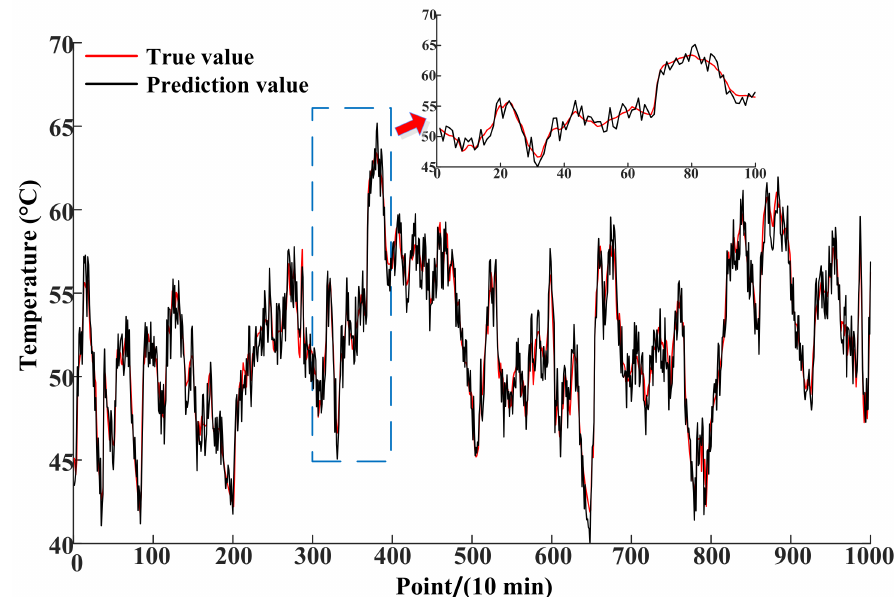
Figure 8. Validation results of the prediction model.